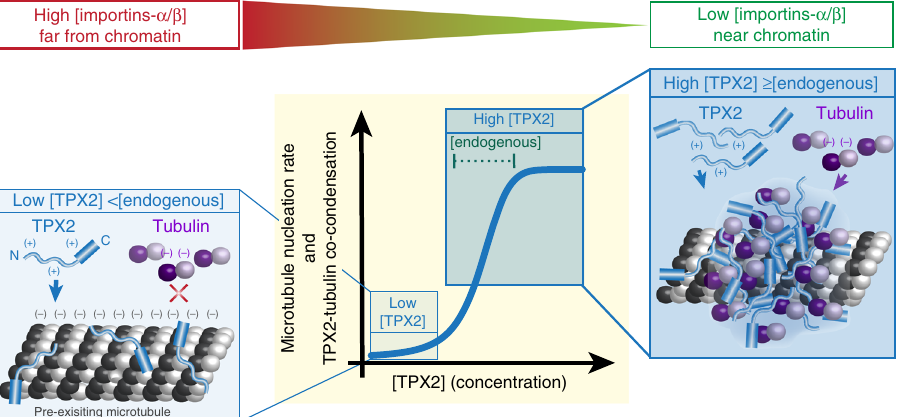
Fig. 7 Model. Left-side cartoon: at low concentrations (<endogenous), TPX2 localizes to MTs but does not recruit soluble tubulin, likely due to electrostatic repulsion (denoted by “ + ” and “ − ” ). Right-side cartoon: at high concentrations of TPX2 ( ≥ endogenous), TPX2 colocalizes with soluble tubulin on microtubules. Center: graphical abstraction of data demonstrating that TPX2 promotes branching MT nucleation (in the cytosol) and forms a co- condensate with tubulin (in vitro) in a switch-like manner at or above its endogenous concentration. Top gradient: relative importin- α / β levels existing as a gradient around chromosomes also affect TPX2-tubulin co-condensation and TPX2-mediated branching MT